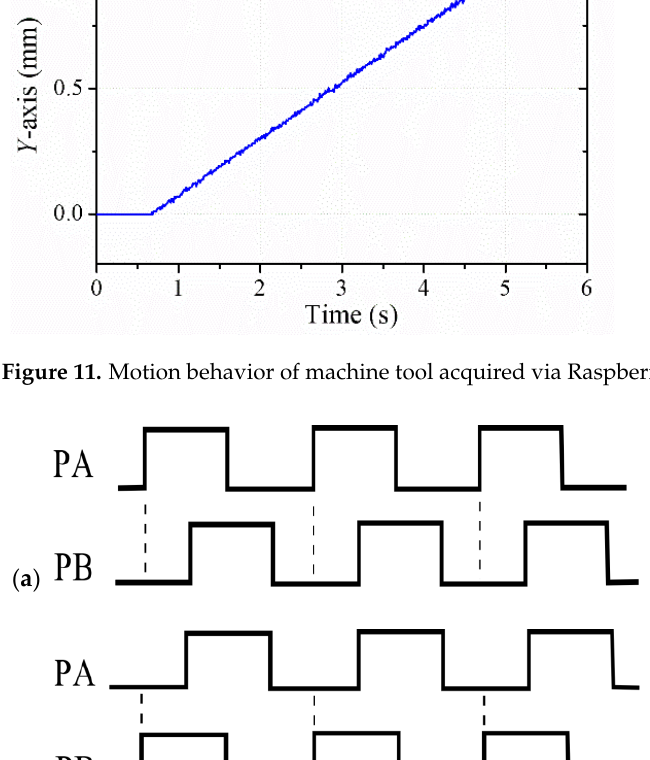
Figure 11. Motion behavior of machine tool acquired via Raspberry Pi.